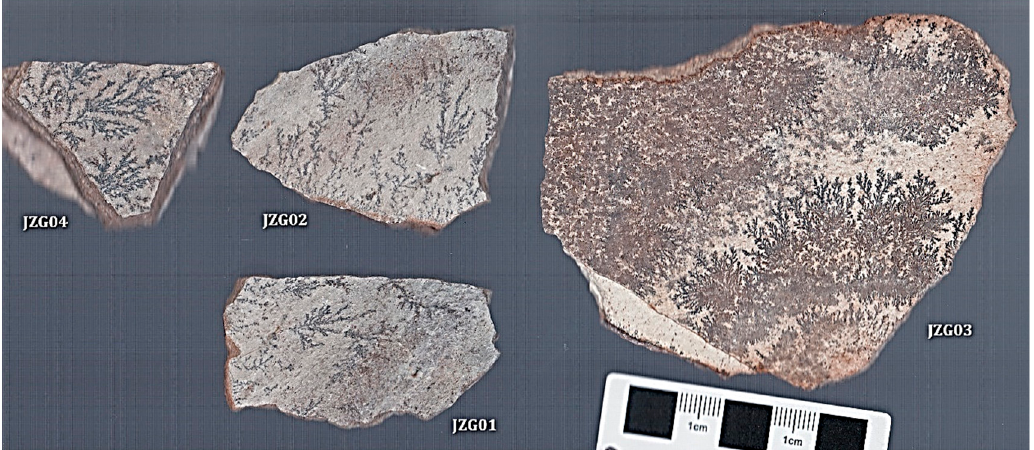
Figure 1. Dendrites in Zhoukoudian, Beijing, China. JZG01, JZG02, and JZG04 are limestone; JZG03 is marble.